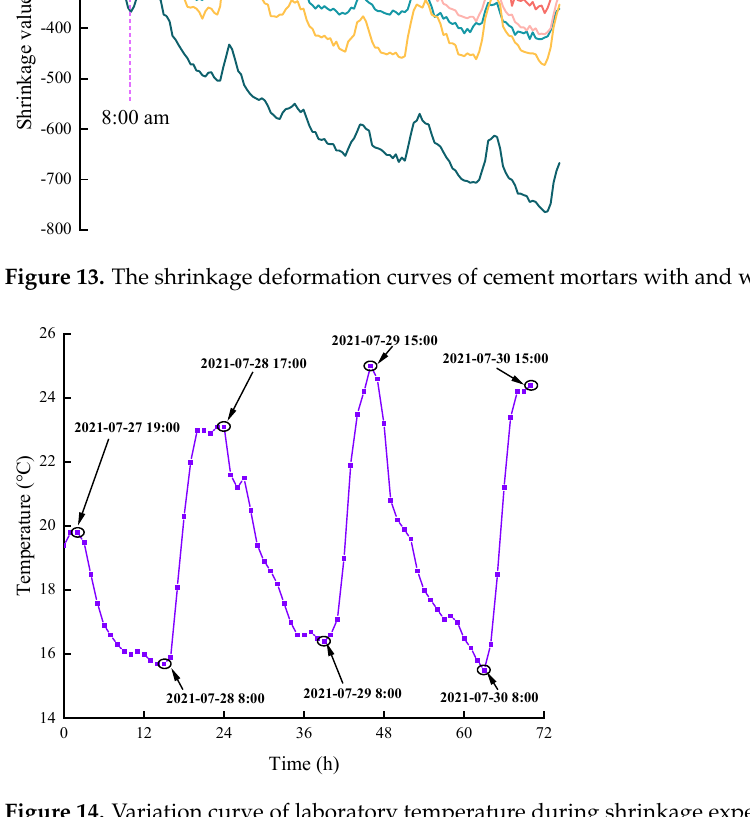
Figure 14. Variation curve of laboratory temperature during shrinkage experiment.